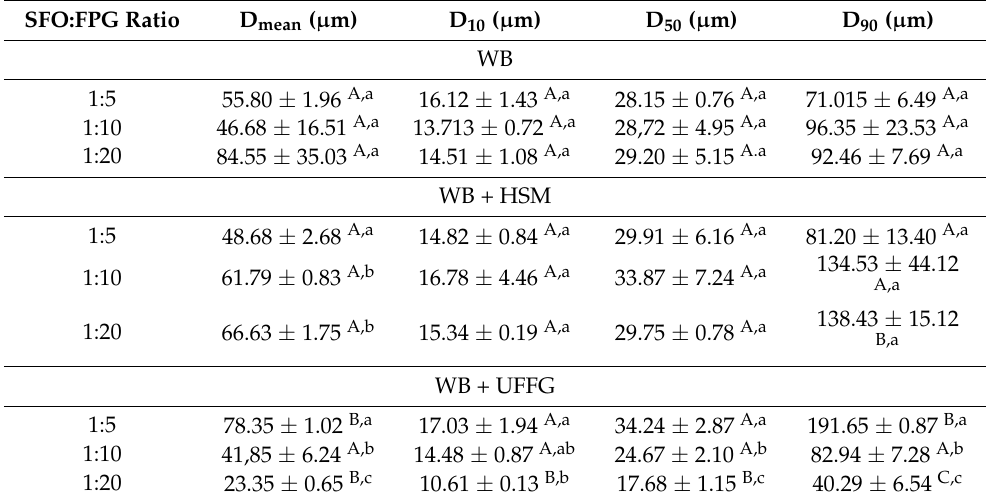
Different letters for each concentration indicate that the results are statistically different ( p < 0.05). Capital letter— comparison at different treatments for each FPG:SFO ratio. Lowercase letter—comparison at different FPG:SFO for each